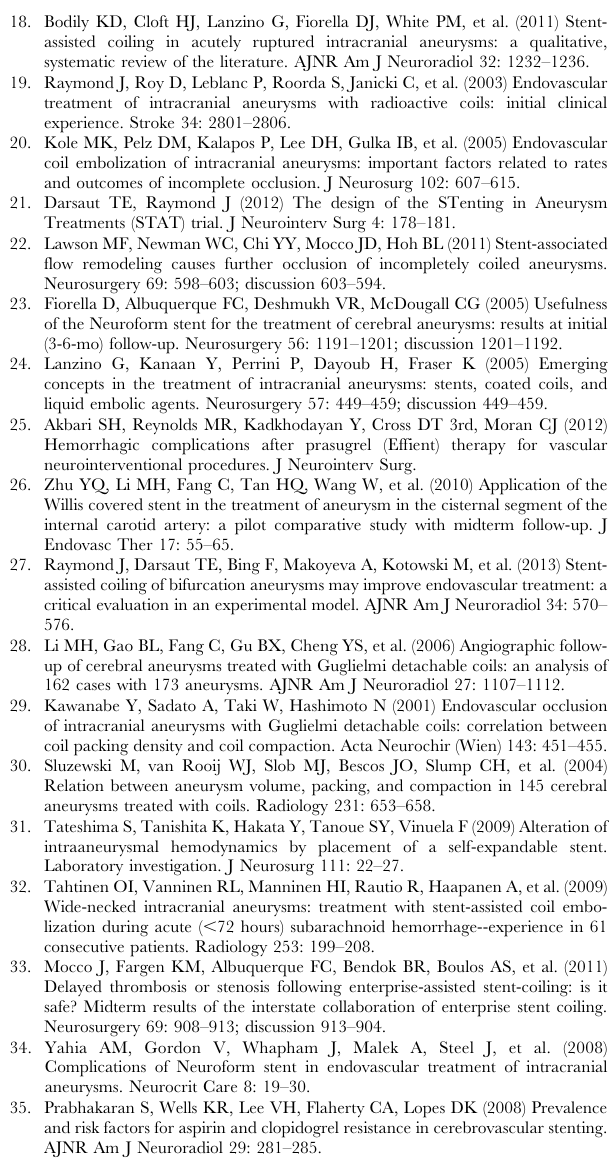
Figure S4 Forest plot of thromboembolic complication rate comparing stent-assisted coiling versus coiling only. Fixed-effect model was applied. (TIF) Figure S5 Funnel plots . Immediate occlusion rate (A), progressive thrombosis (B), all-complication rate (C), recurrence rate (D), mortality rate (E), permanent complication rate (F), thromboembolic complication rate